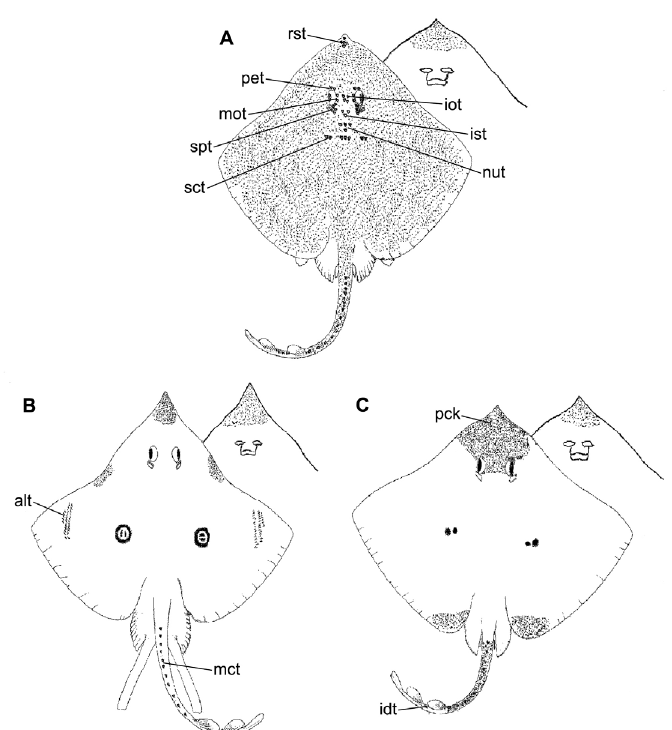
FIGURE 3 | Dorsal squamation of Atlantoraja species. A , A. castelnaui . B , A. cyclophora . C , A. platana . Modified from Figueiredo (1977). alt , alar thorn; idt , interdorsal thorn; iot , interorbital thorn; ist , interspiracular thorn; mct , mediocaudal thorn; nut , nuchal thorn; pck , prickles; pet , preorbital thorn; rst , rostral thorn; sct , scapular thorn; spt , spiracular